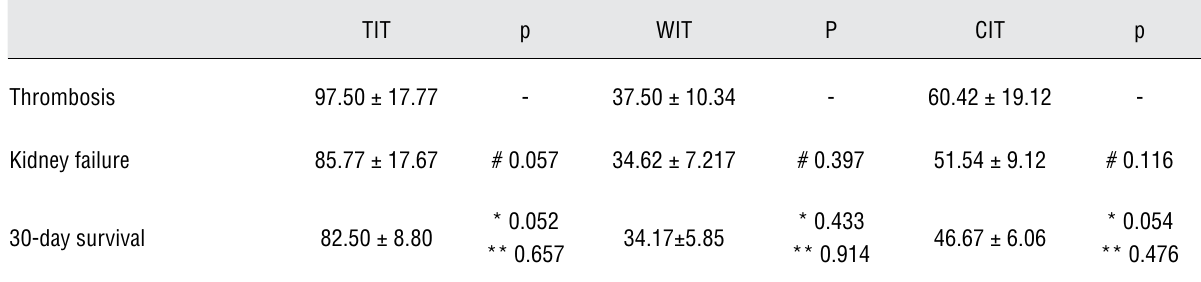
Table 3 - Ischemia times in different